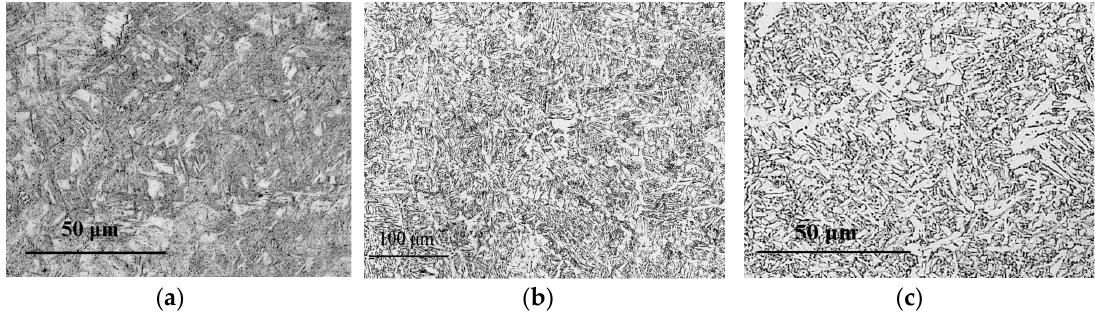
Figure 13. Microstructure of ( a ) the laser zone, ( b ) centre line after single pass and ( c ) centre line after second pass (reproduced from [80] with permission, Elsevier, 2017).